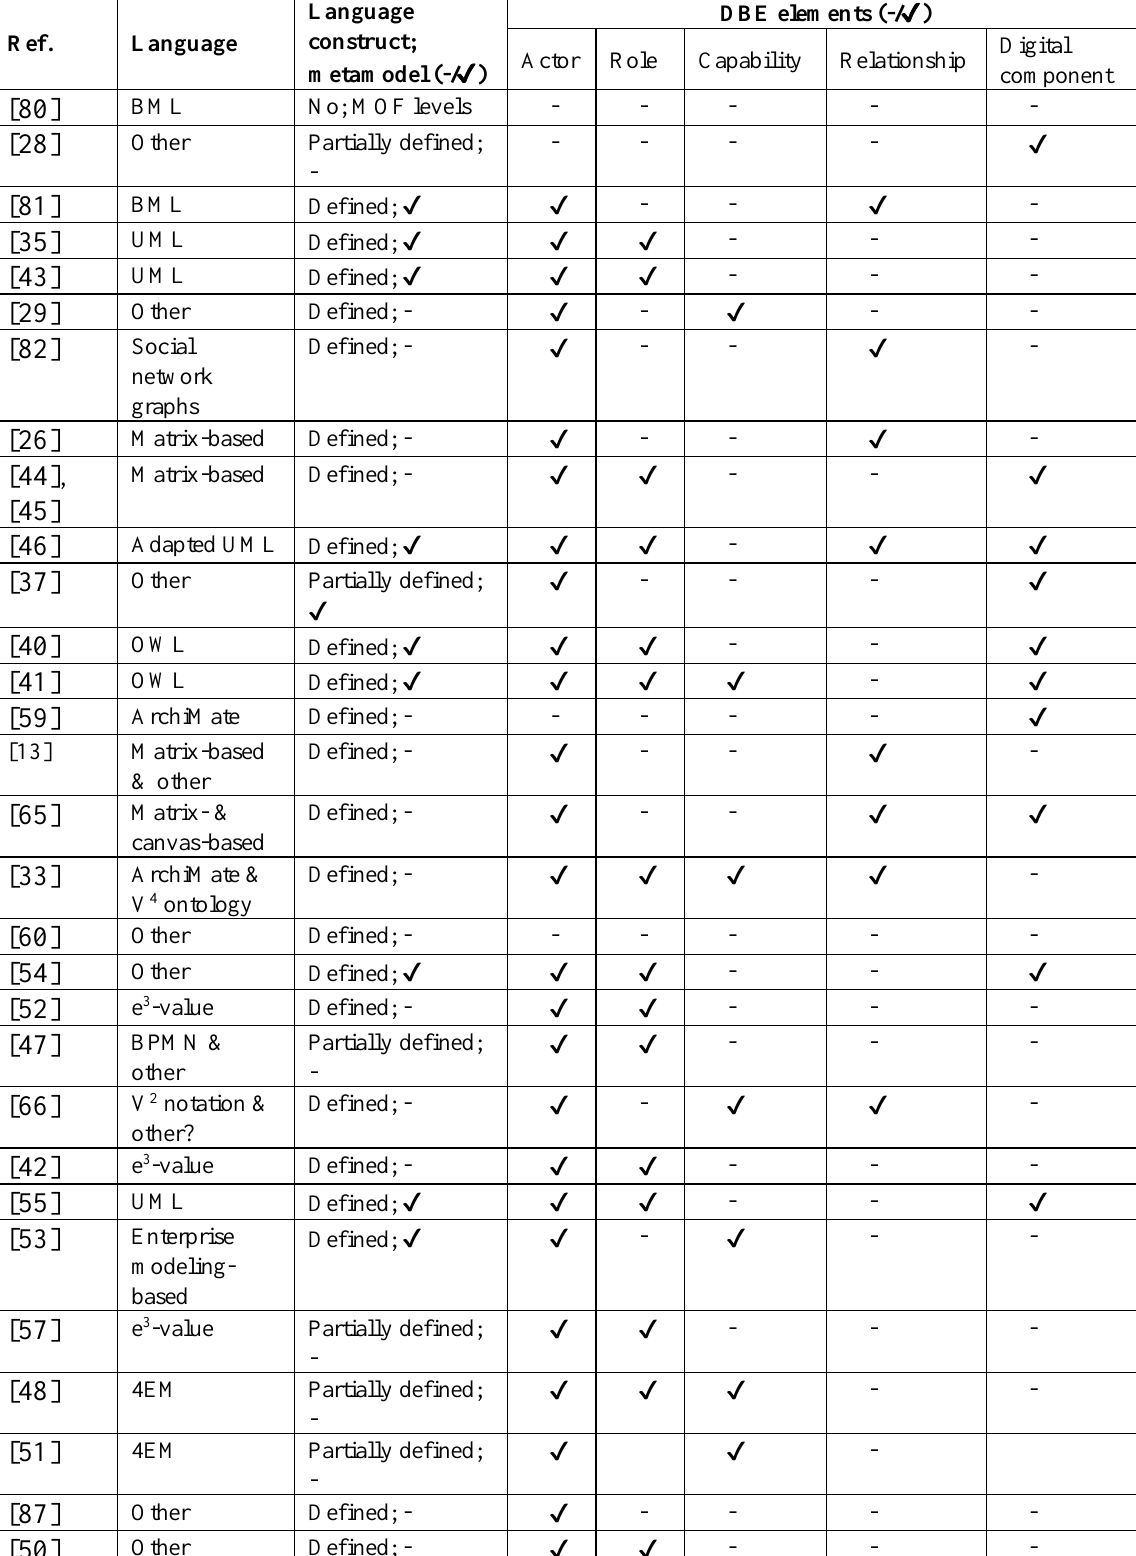
Table 6. Application of language constructs, metamodels, and DBE elements